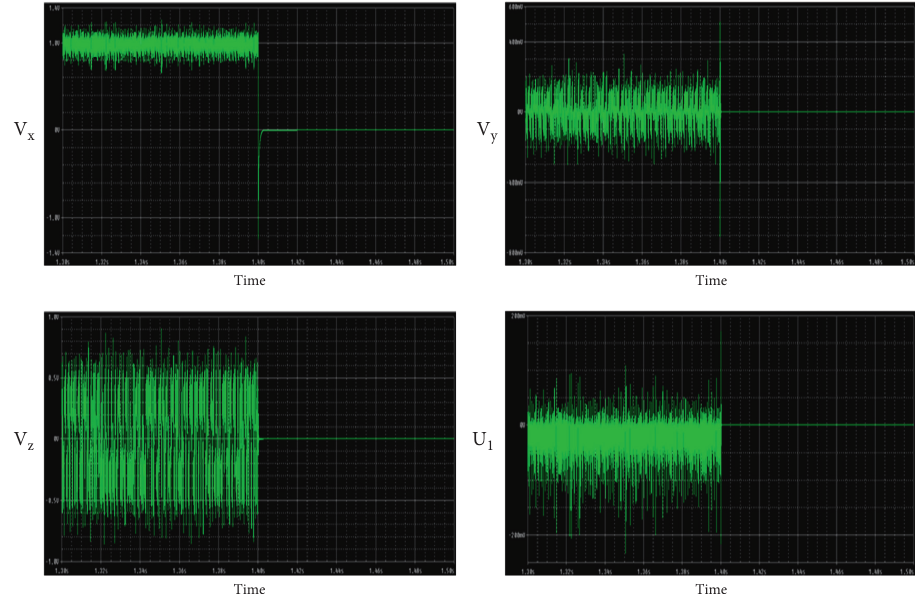
Figure 9: Time series of chaos suppression in SynRM without external inputs generated from the Pspice oscilloscope for the capacitors and resistors: C